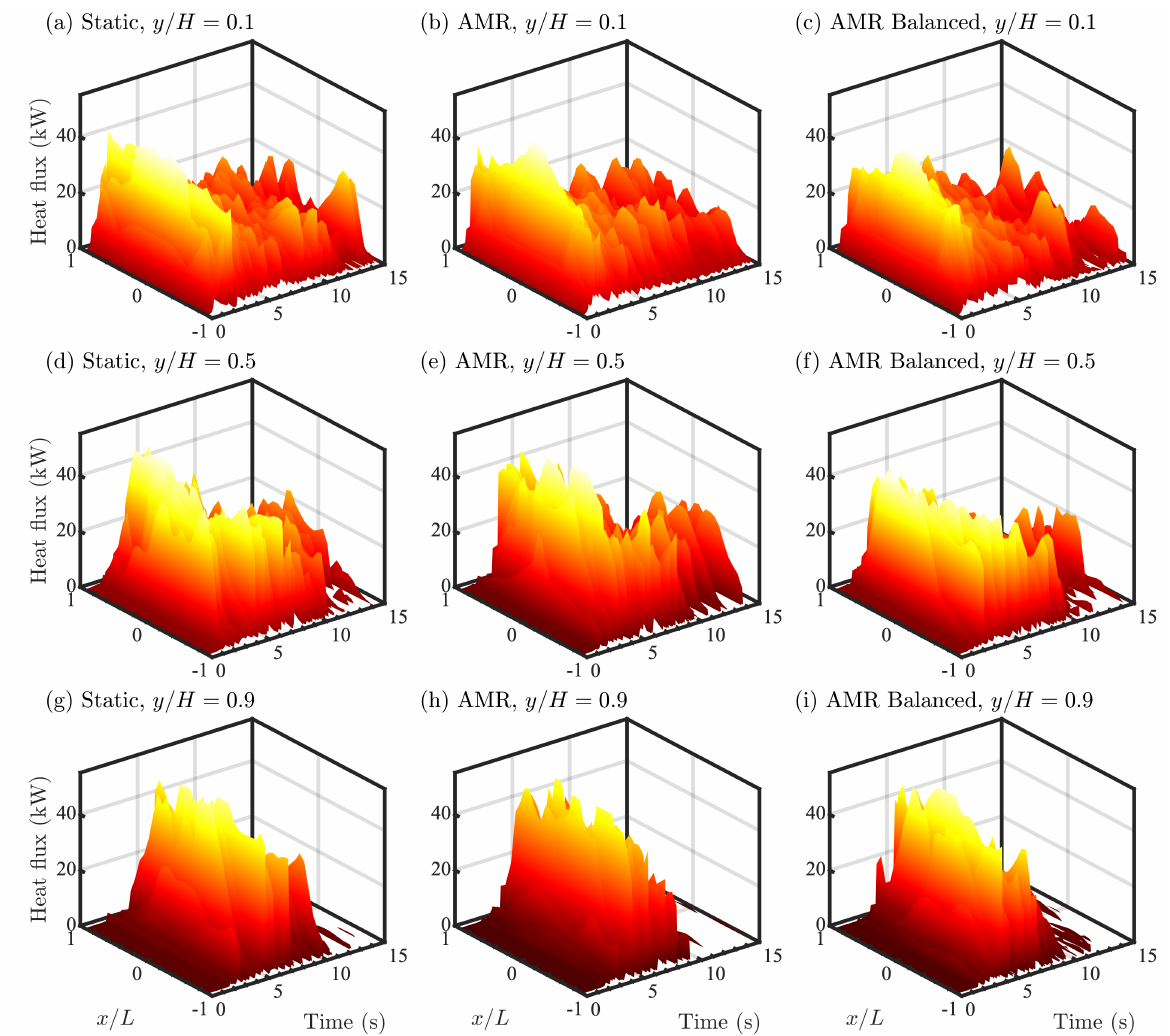
Figure 6. Time histories of gas-phase heat flux to the solid across the panel, near the gas–solid interface, for the single panel vertical fire spread verification test case. Rows from top to bottom show time histories at panel heights of z / H = 0.1, 0.5, and 0.9, where H = 2.4 m is the total height and columns from left to right correspond to static, AMR, and balanced AMR cases, respectively. Temperatures are colored from low (black) to high (yellow). The transverse location x is normalized by the half panel width L = 0.3 m in all